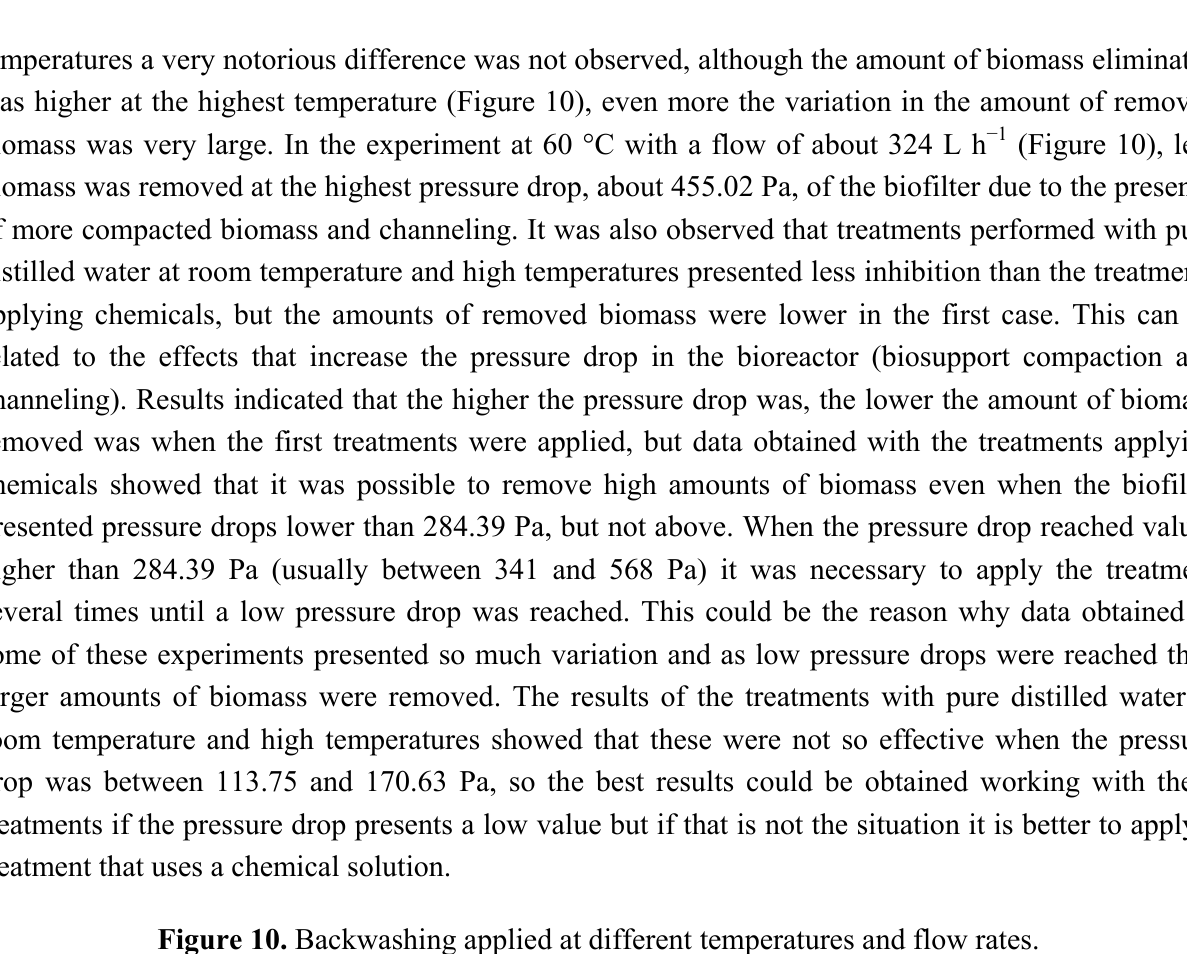
Figure 10. Backwashing applied at different temperatures and flow